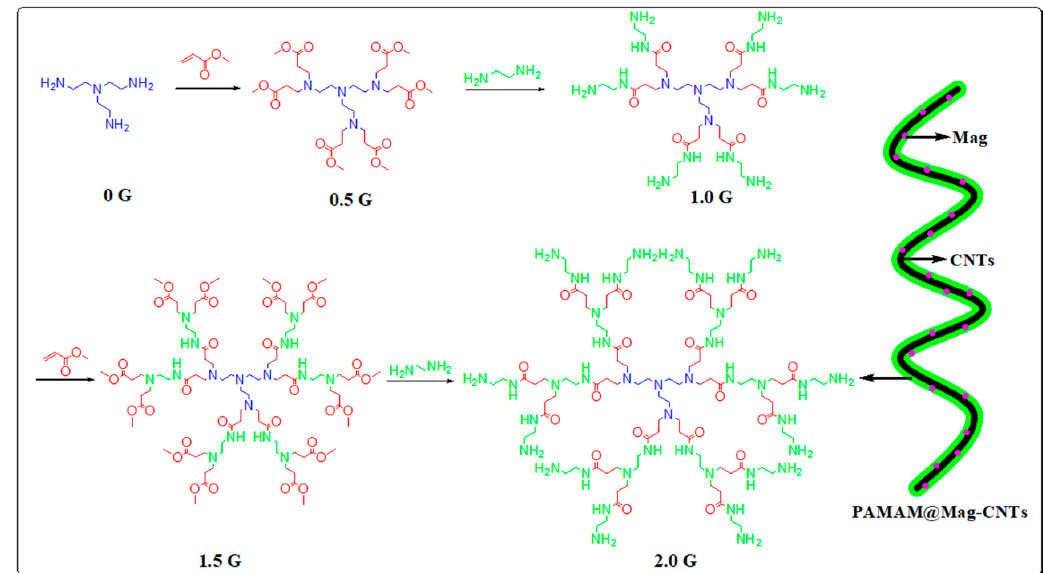
Figure 15. The synthetic process of PAMAM. Reprinted with permission from Ref. [113]. Copyright (2018) Royal Society Chemistry.